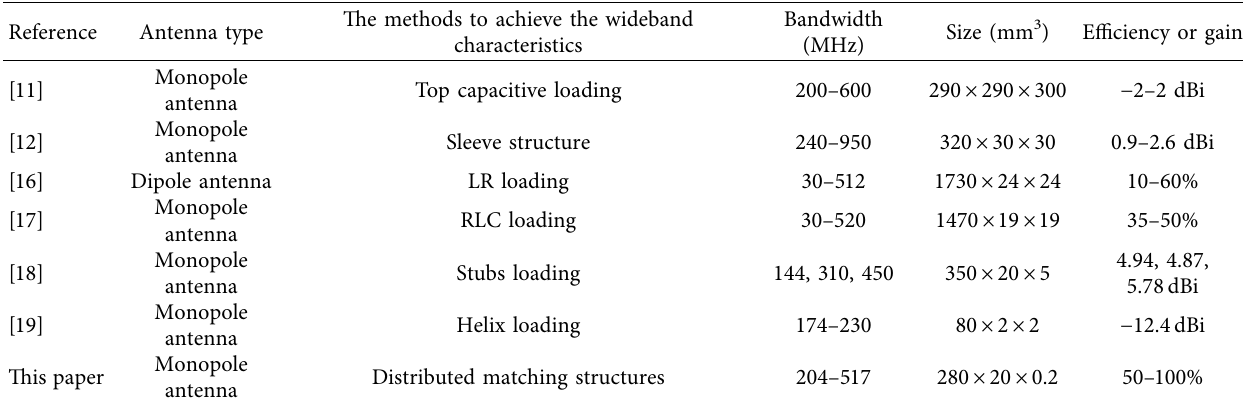
Figure 11: (a) VSWR curves and (b) Smith charts with different values of w 5 with other variables unchanged. Table 2: The comparisons with other